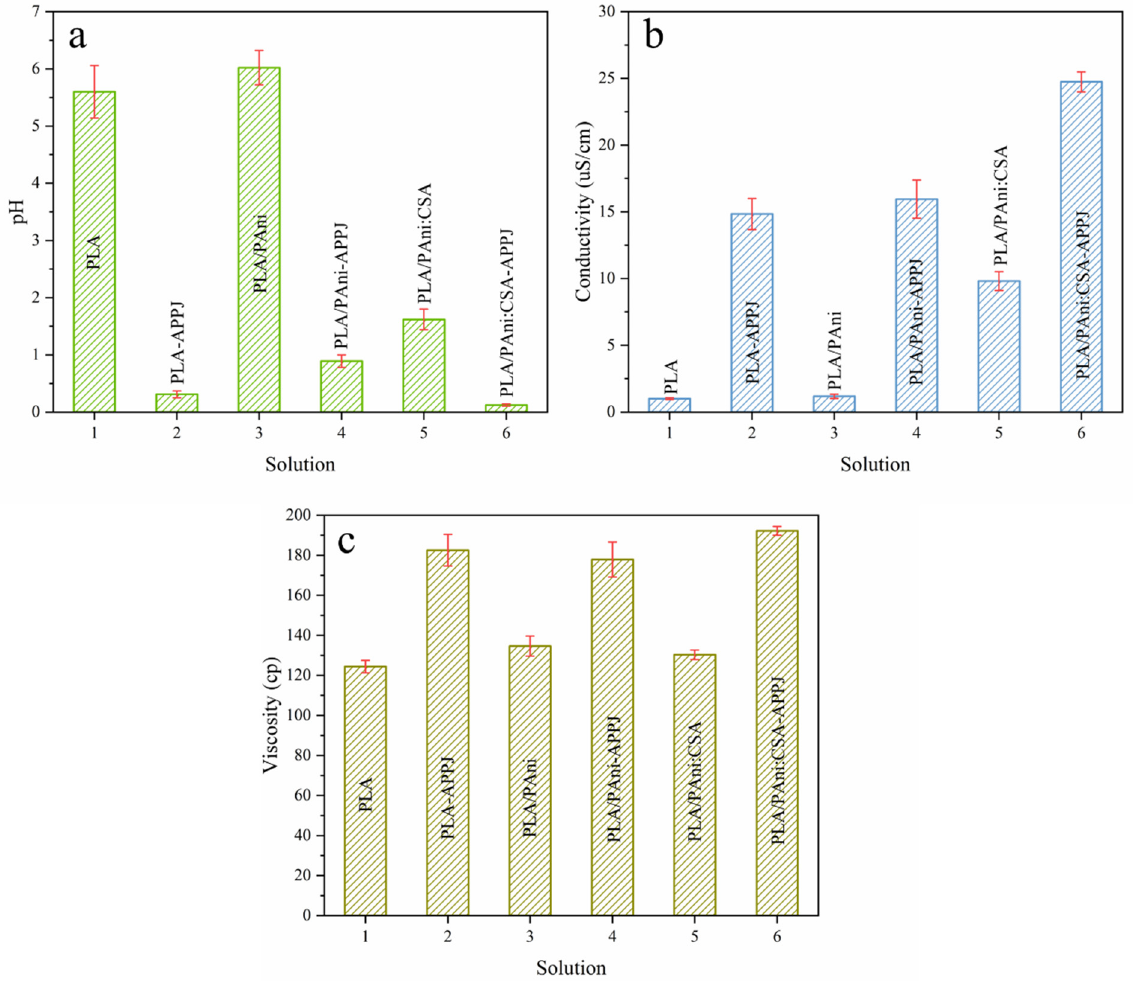
Figure 2. Liquid properties of the different polymer solutions before and after APPJ treatment, ( a ) pH, ( b ) conductivity and ( c ) viscosity.